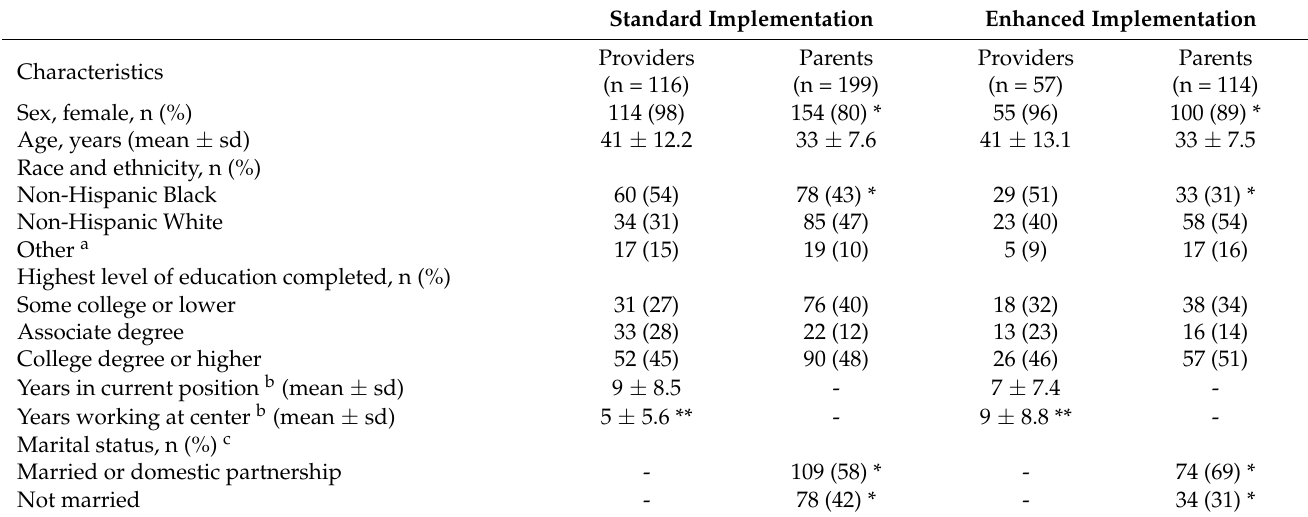
Table 5. Demographic characteristics of early care and education providers (n = 173) and parents (n = 313) implementing Healthy Me , Healthy We